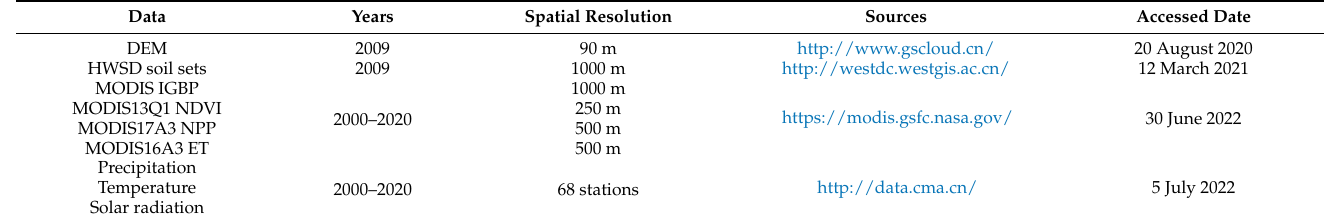
Table 1. Data sources.